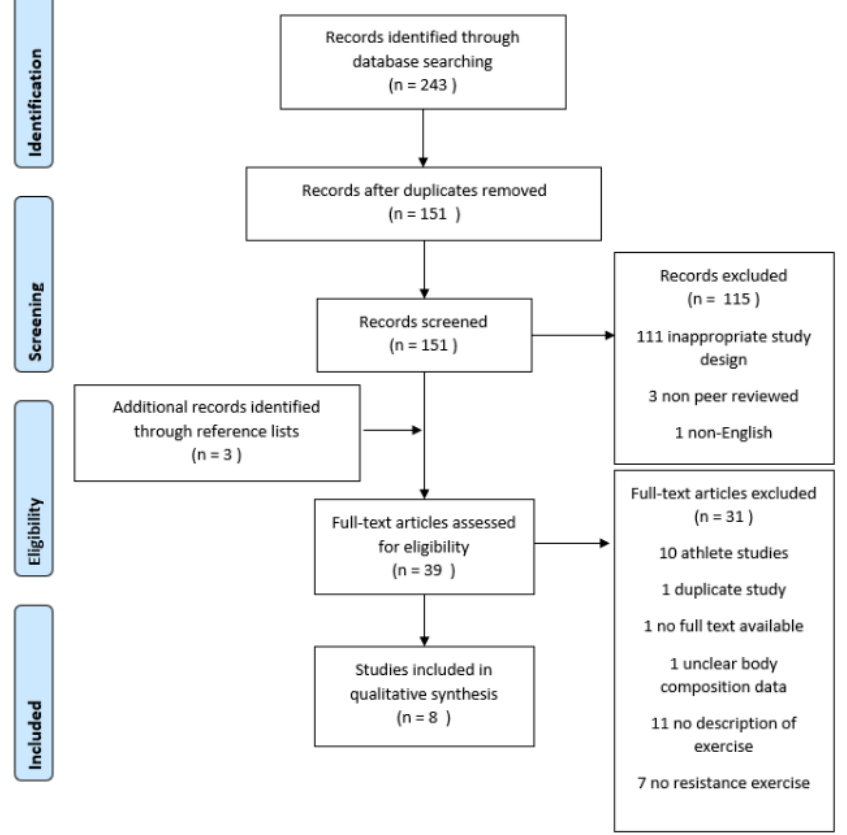
Figure 1. Preferred reporting items for systematic reviews and meta-analyses (PRISMA) flow diagram of study selection.